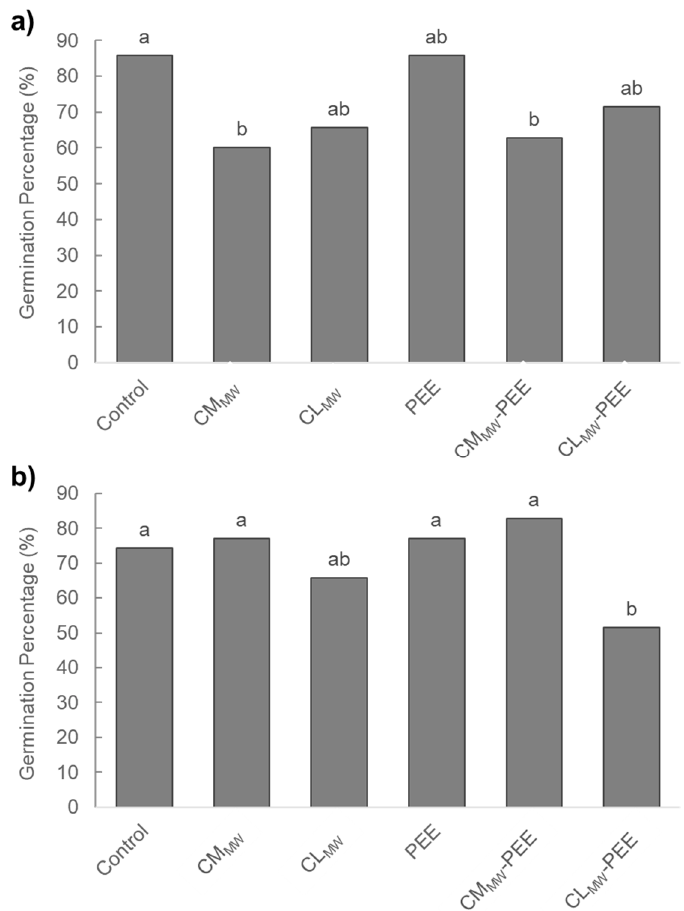
Figure 2. Germination percentage (GP) of ( a ) P. sylvestris and ( b ) P. radiata seeds coated with medium and low molecular weight chitosan (CM MW and CL MW , respectively) and/or with propolis ethanolic extract (PEE) at 40 and 30 days after sowing, respectively. Averages with the same letter were not significantly different according to the Chi-square test ( χ 2 ) ( α ≤ 0.05).